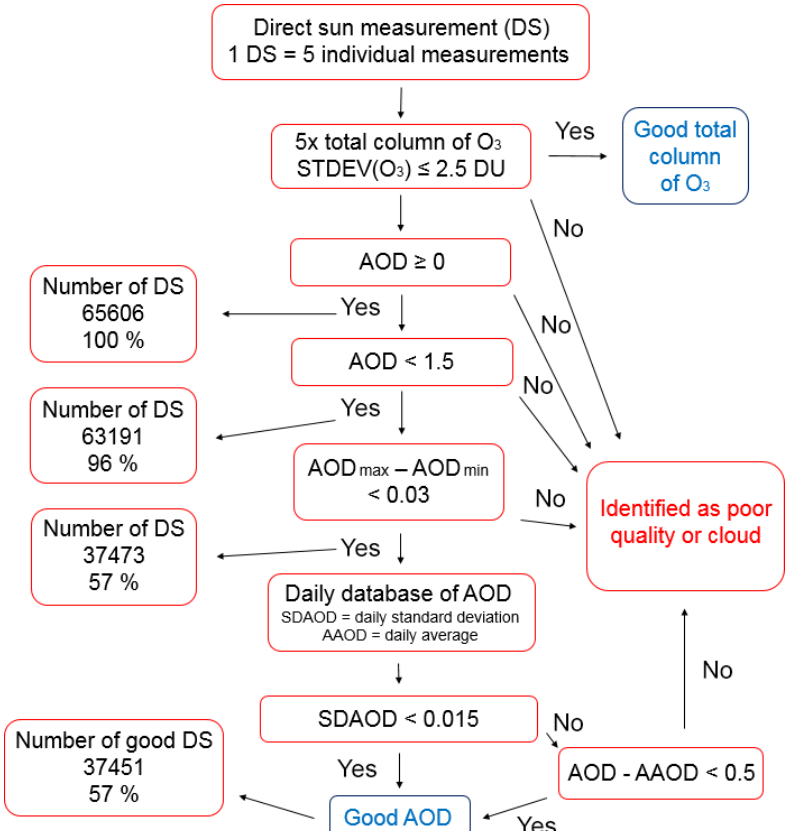
Figure 1. Schematic illustration of the DS measurement quality control procedure that includes cloud screening. The number of DS mea- surements for the period 18 August 1993–13 May 2017 that satisfy the respective criterion is indicated on the left